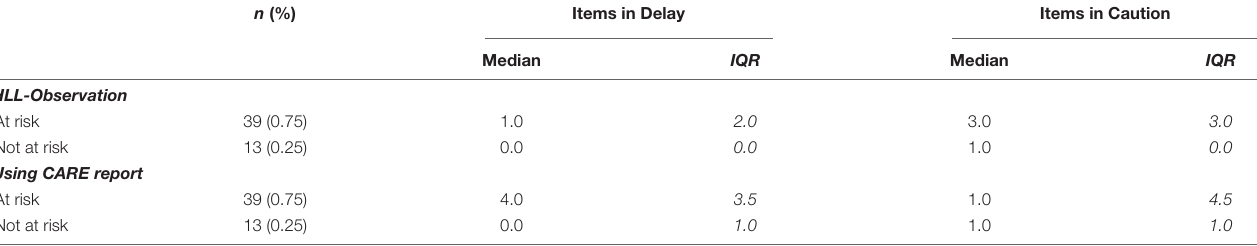
TABLE 4 | Delays and Cautions for nominal classification groups using Haizea-Llevant (HLL) and CARE. n (%) Items in Delay